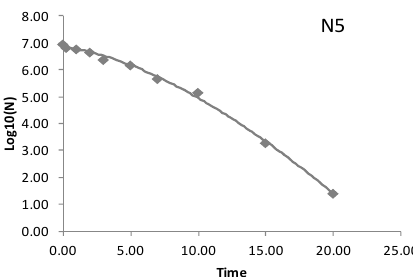
Figure 2. Weibull decline curve of survival of E. coli O157:H7 in the different soils N1–N5. Observed values ( ◆ ) and fitted Weibull decline curve (solid line).